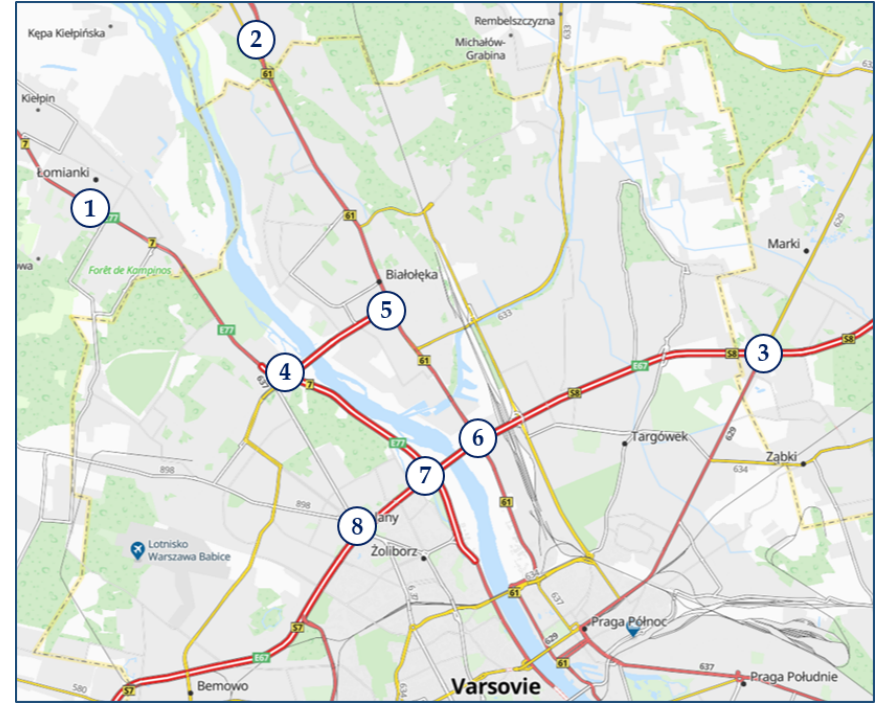
Figure 3. This is a figure. Schemes follow the same formatting. If there are multiple panels, they Figure 3. Road map with road nodes plotted. should be listed as: ( a ) Description of what is contained in the first panel. ( b ) Description of what is contained in the second panel. Figures should be placed in the main text near to the first time they are cited. A caption on a single line should be centered.